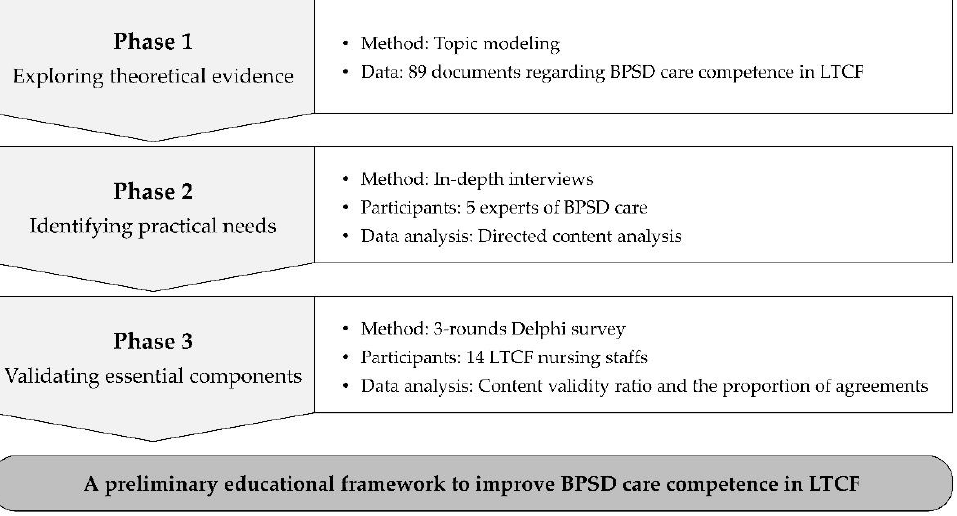
Figure 1. Overview of the research process.